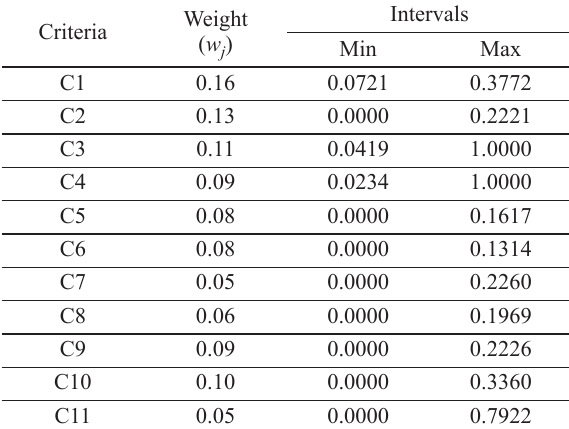
Table 7. Stability intervals